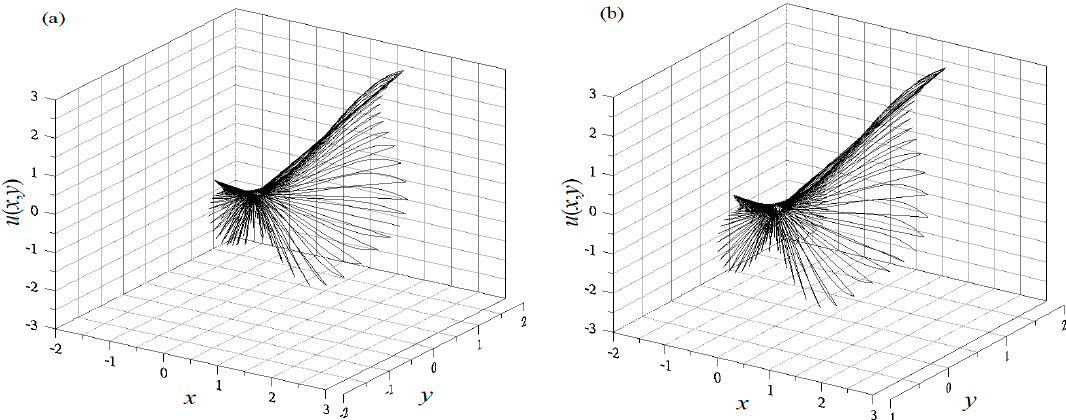
Figure 20. The numerical solutions for the steady-state AC equation with amoeba-like irregular domain are shown in ( a ), and in ( b ) the proposed approach solution with random noise.